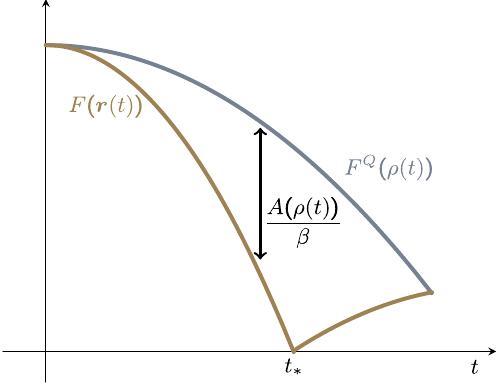
FIG. 9. Free energy stored in coherence. Under a Markovian master equation with a thermal fixed point, the quantum free energy F Q is monotonically decreasing in time. Since F Q ¼ F þ A= β , part of the classical component F can be stored in the coherent component A at times t ≤ t and recovered later. (cid:3) At time t ¼ t , the population is thermal, so the classical free (cid:3) energy is at a minimum; however, A ≠ 0 , so F Q is above the minimum. For t ≥ t , part of this coherent free energy is (cid:3) converted back into classical free energy. Hence, the latter undergoes a backflow, which classically would require memory